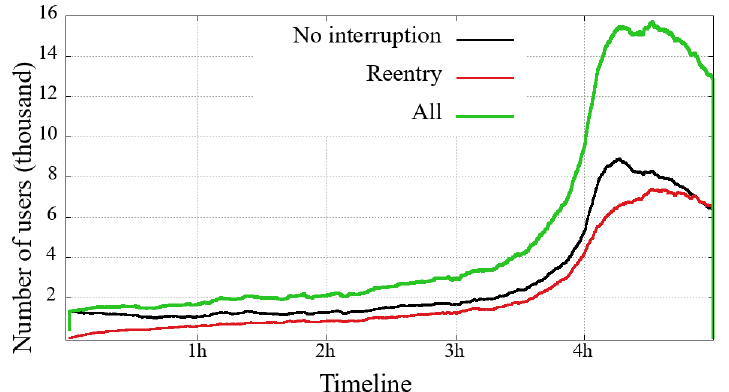
Figure 12. Mobile users on the system in the broadcasting session of Opening Rio 2016 Olympic Games.